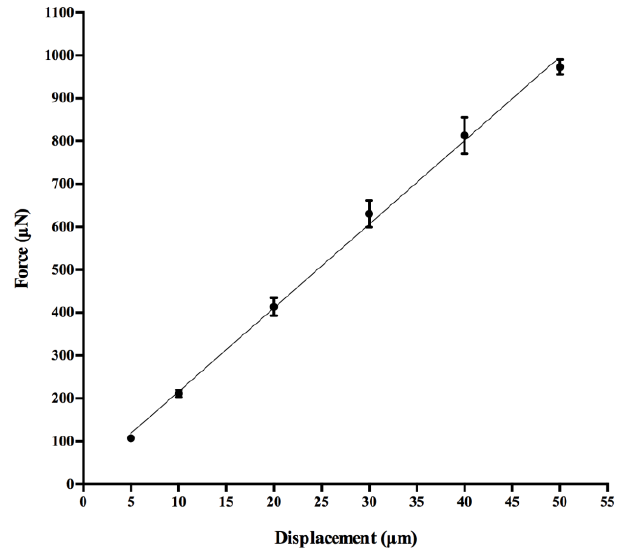
Figure 7. Linear regression for the force values measured by the micro-force transducer during the pin calibration procedure. For each displacement input, mean ± SD of the measured force are displayed.